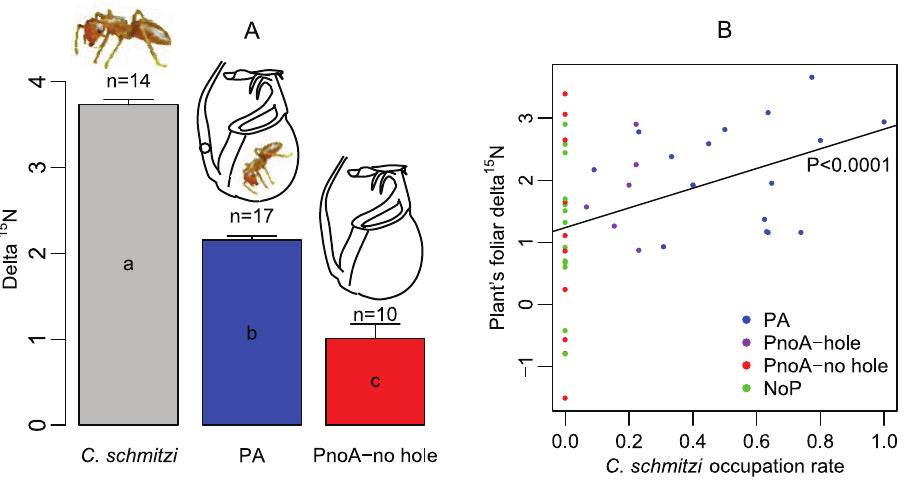
Figure 5. Isotopic signature ( d 15 N) of samples and assessment of myrmecotrophy. ( a ) Mean d 15 N compared between C. schmitzi , plants occupied by C. schmitzi (referred as PA plants) and plants that have not been occupied by C. schmitzi (referred as PnoA -no hole ). These three signatures were used to estimate the percentage of foliar nitrogen derived from the ants. The error bars denote 1 S.E. ( b ) Foliar d 15 N of N. bicalcarata as an increasing function of C. schmitzi occupation rate. As a consequence the percentage of foliar N derived from the ants also increased with ant occupation rate.